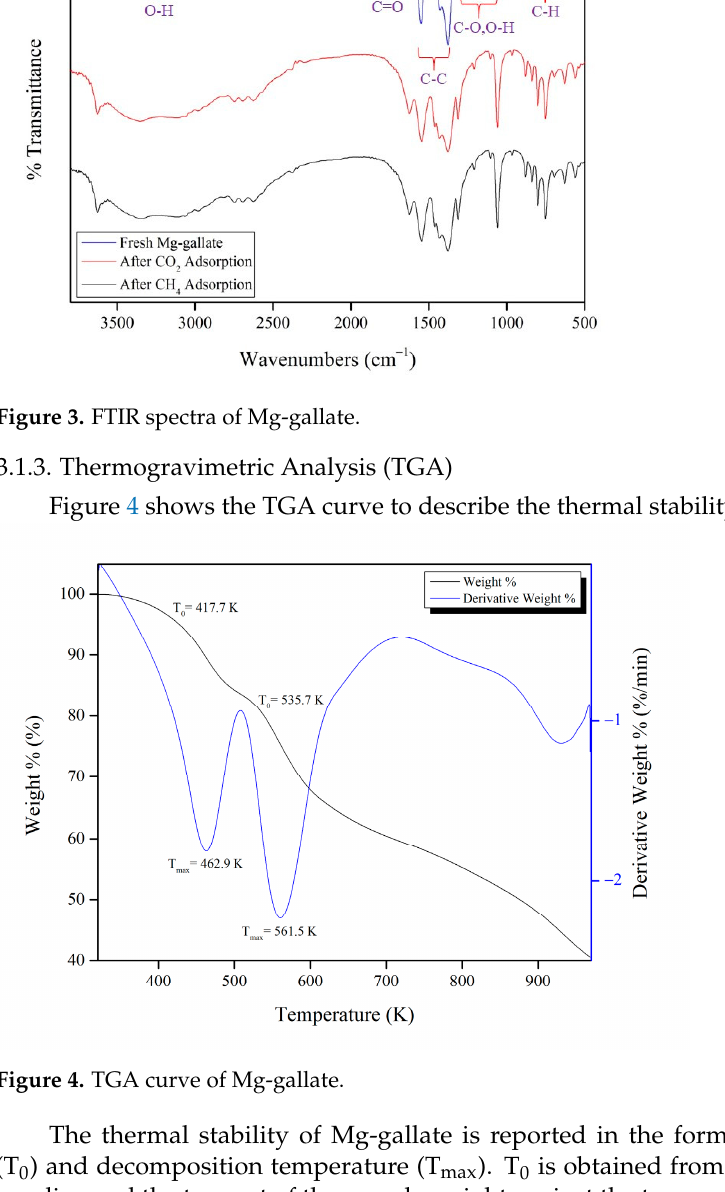
Figure 3. FTIR spectra of Mg-gallate.